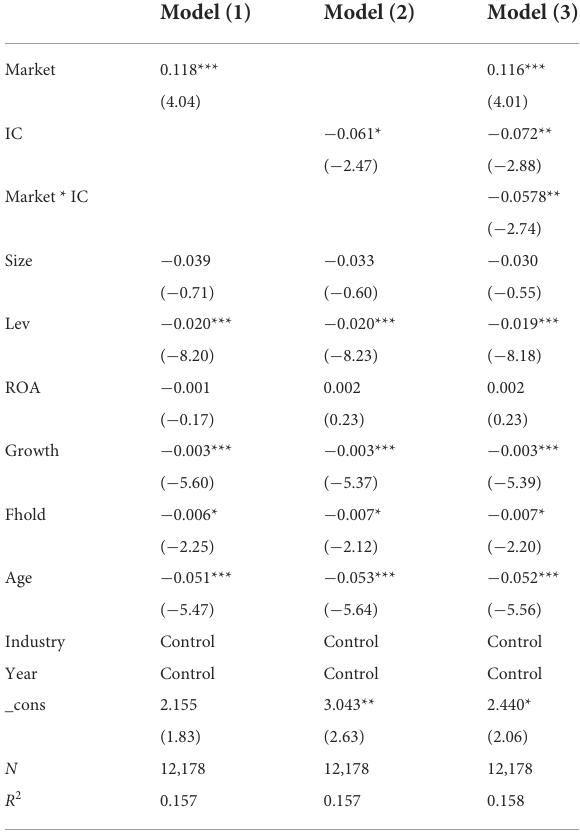
TABLE 8 Regression results by substituting independent